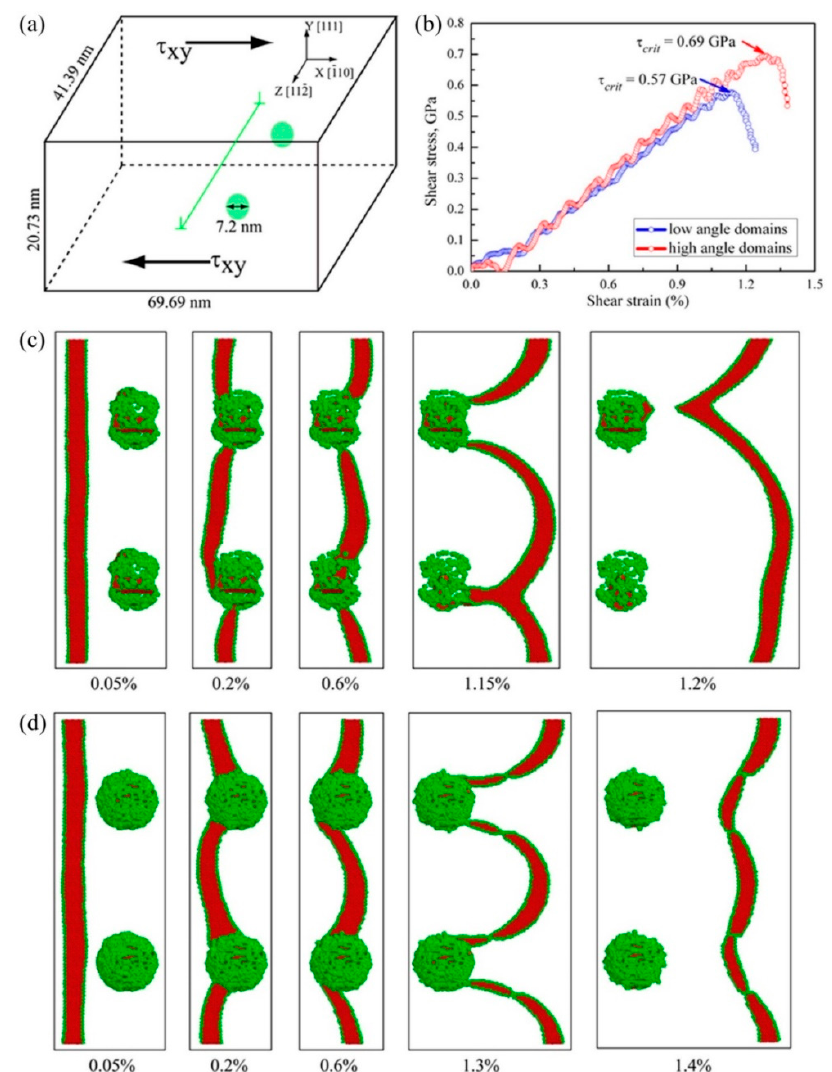
Figure 16. MD simulations of slip-nanodomain interactions. ( a ) Configuration for simulation cell with a straight edge dislocation and two nanodomains. ( b ) Simulated shear stress-shear strain curves as the straight dislocation is blocked by the nanodomains. ( c ) A sequence of snapshots at varying shear strains showing the pinning of the dislocation and its subsequent bowing around the nanodomains with LADB. ( d ) A sequence of snapshots at varying shear strains showing the pinning of the dislocation and its subsequent bowing around the nanodomains with high-angle domain boundaries (HADB). Adapted from [119].